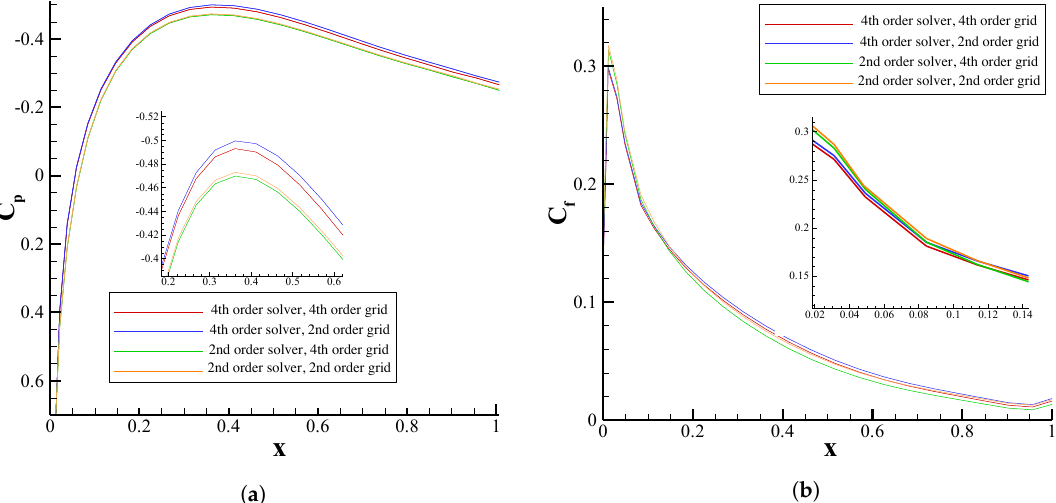
Figure 13. Comparison of the ( a ) pressure and ( b ) skin friction coefficients obtained using second- and fourth-order flow solvers with different generated grids for flow around a NACA 0012 airfoil with Ma = 0.85 and Re = 500.